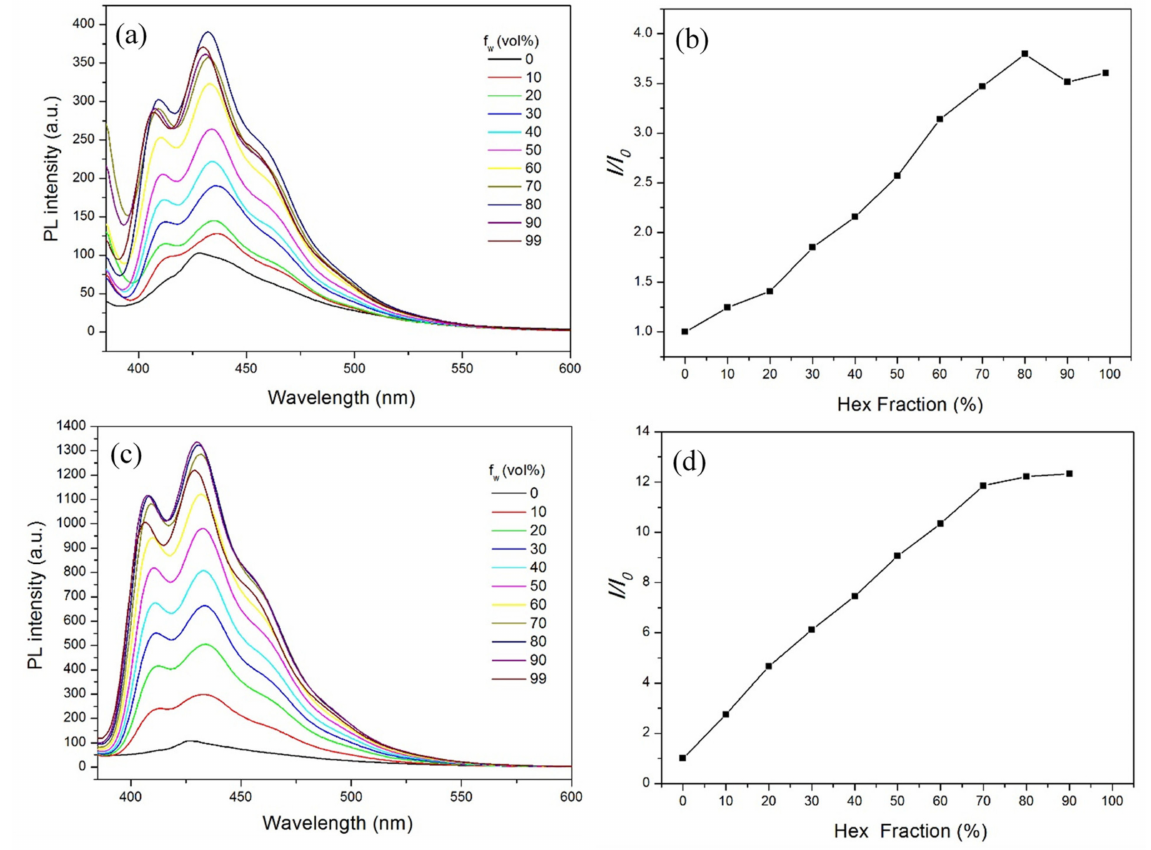
Figure 4. PL spectra and changes in relative PL intensity versus different water fractions of n-TPE ( a , b ) and n-TPE-AP-PDMS ( c , d ) in THF/n-hexane mixtures. λ ex = 375 nm; concentration: 10 µ M. (The chosen wavelength for the calculation of “ I/I 0 ” is 435